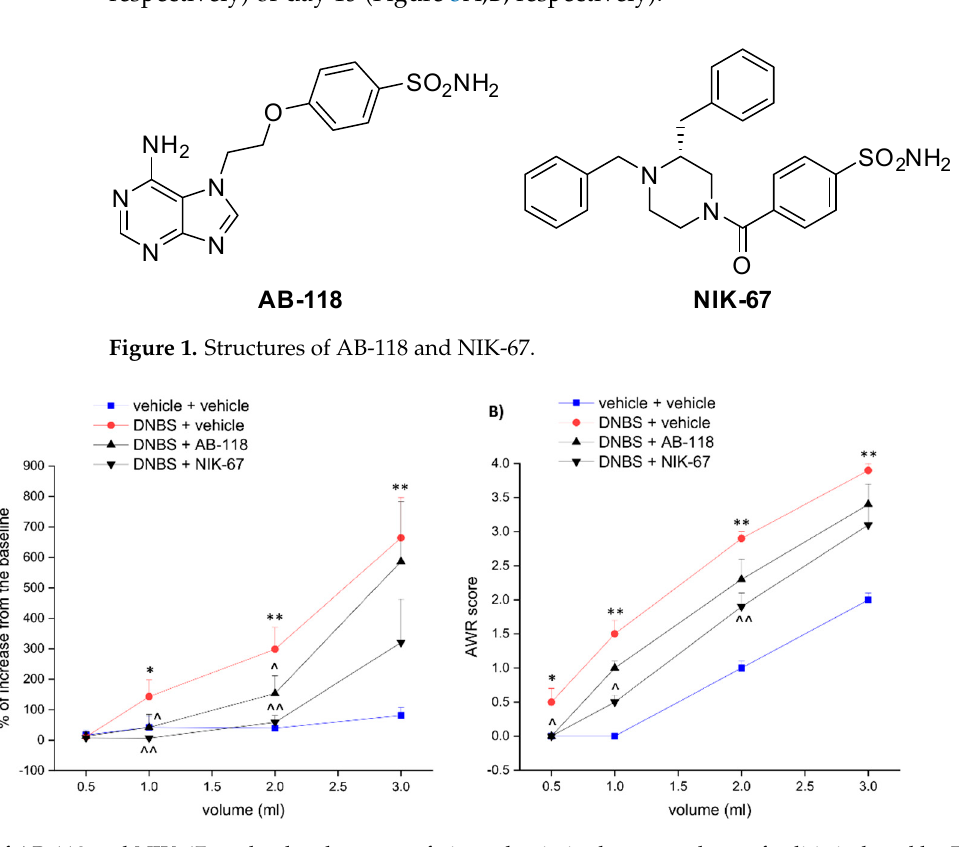
Figure 2. Effect of AB-118 and NIK-67 on the development of visceral pain in the acute phase of colitis induced by DNBS in rats. Tests were performed 8 days after DNBS injection, 24 h after the last administration of the CAIV inhibitor, AB − 118 or NIK − 67 (75 mg kg − 1 p.o.). Visceral sensitivity was assessed by measuring ( A ) the animals visceral motor response (VMR) and ( B ) the abdominal withdrawal response (AWR) to colon rectal distension (0.5, 1, 2, 3 mL balloon inflation). Each value is the mean ± S.E.M. and represents the mean of 5 rats per group. * p < 0.05 and ** p < 0.01 vs. vehicle + vehicle treated animals. ˆ p < 0.05 and ˆˆ p < 0.01 vs. DNBS + vehicle-treated animals.